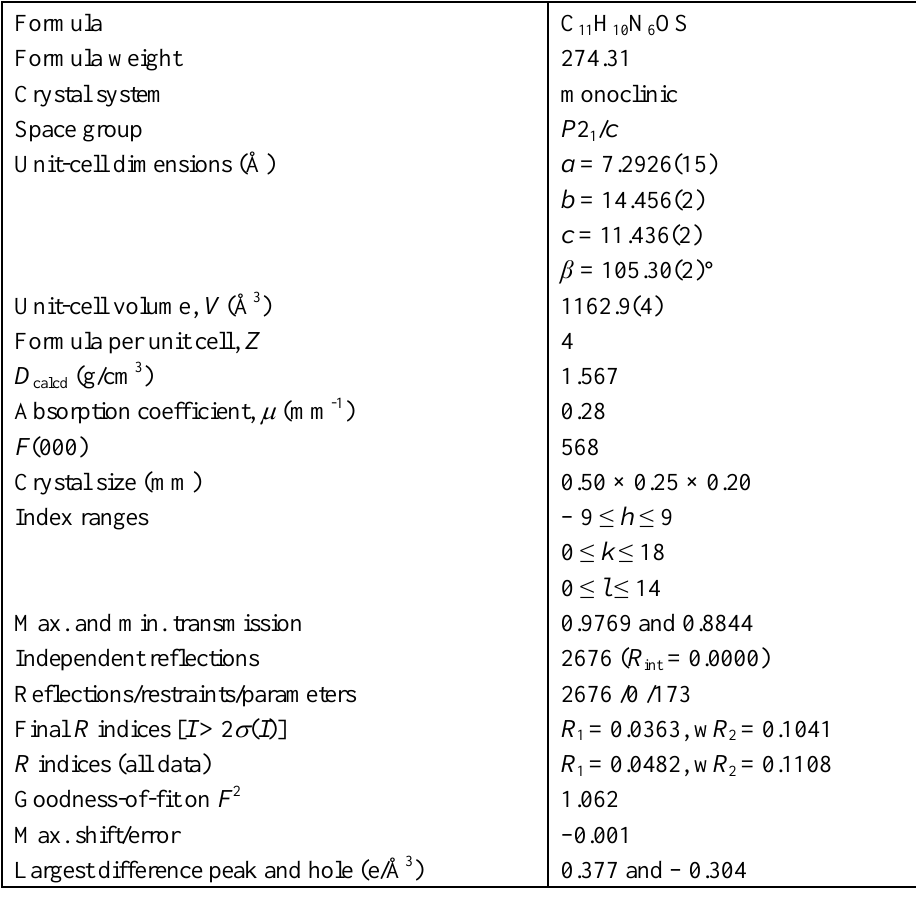
Table 2. Crystal and experimental data for compound